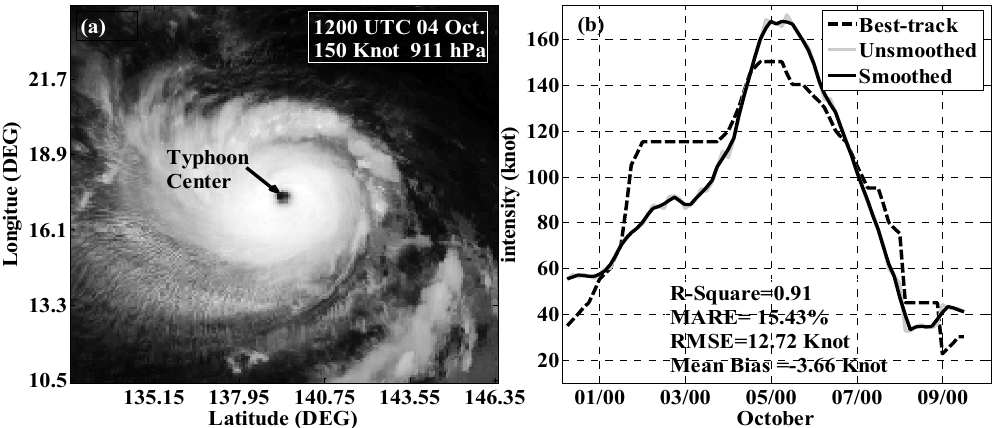
Figure 9. ( a ) IR image of typhoon Melor (2009) at 12:00 p.m. UTC 4 October, the arrow indicates the typhoon center derived from JTWC best-track dataset; ( b ) The intensity sequence estimated using the model developed in this paper (gray solid curve), the curve that is 12-h smoothed (black solid curve), and that from best-track (black dashed curve).